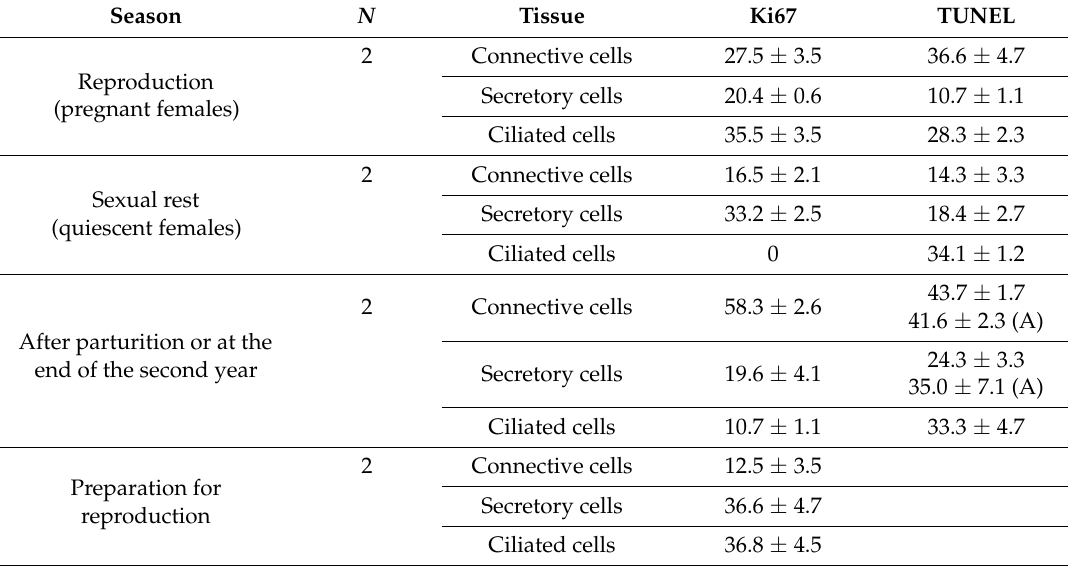
Table 8. Proliferation indexes (Ki67) and percentages of apoptotic cells (TUNEL/Apostain) in the uterus of Typhlonectes compressicauda during the year. (A): apoptosis detected with Apostain method. N : number of